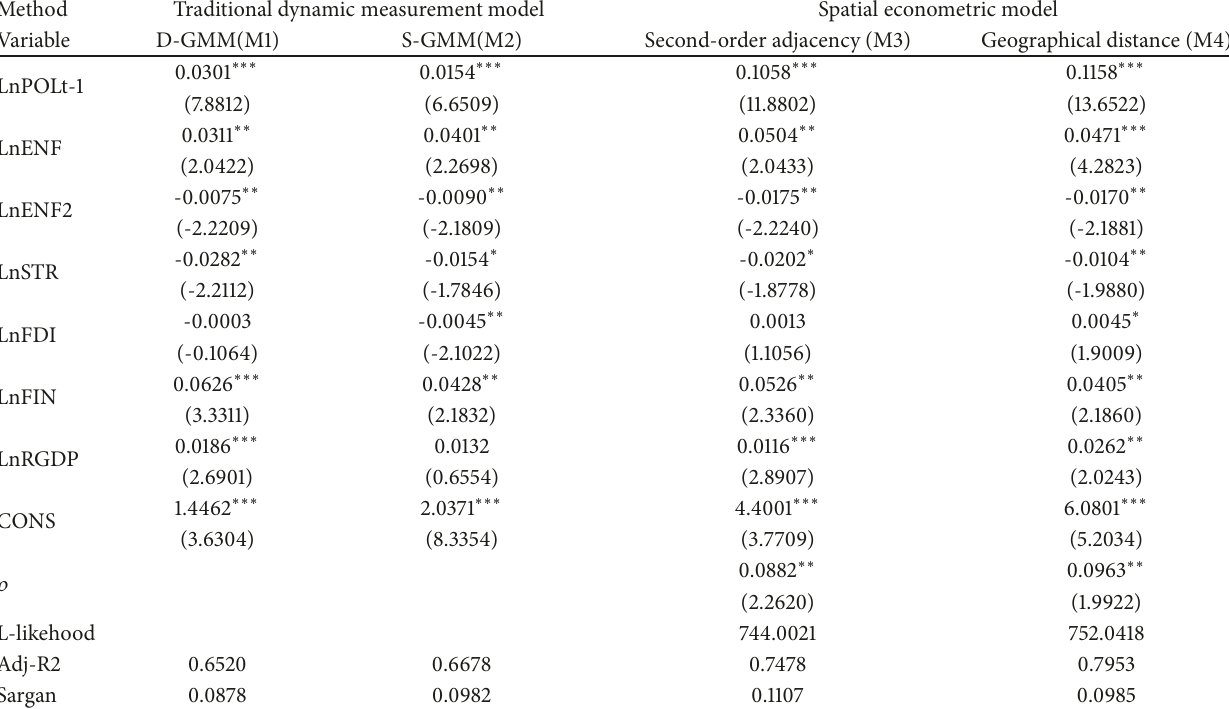
Table 2: Fee-based environmental regulation and regression results of environmental pollution measurement.